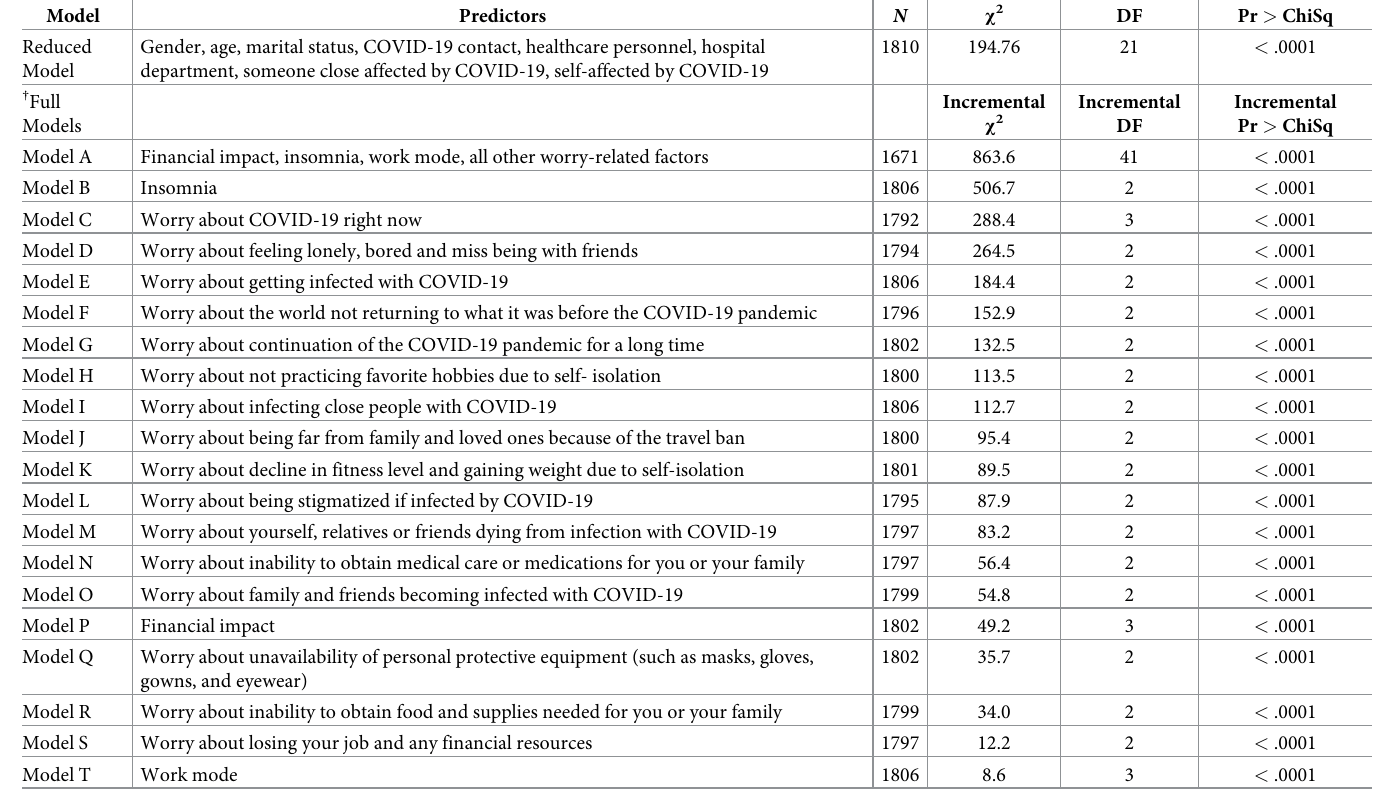
Table 4. Likelihood ratios for proportional odds models with non-modifiable and modifiable correlates predicting psychological